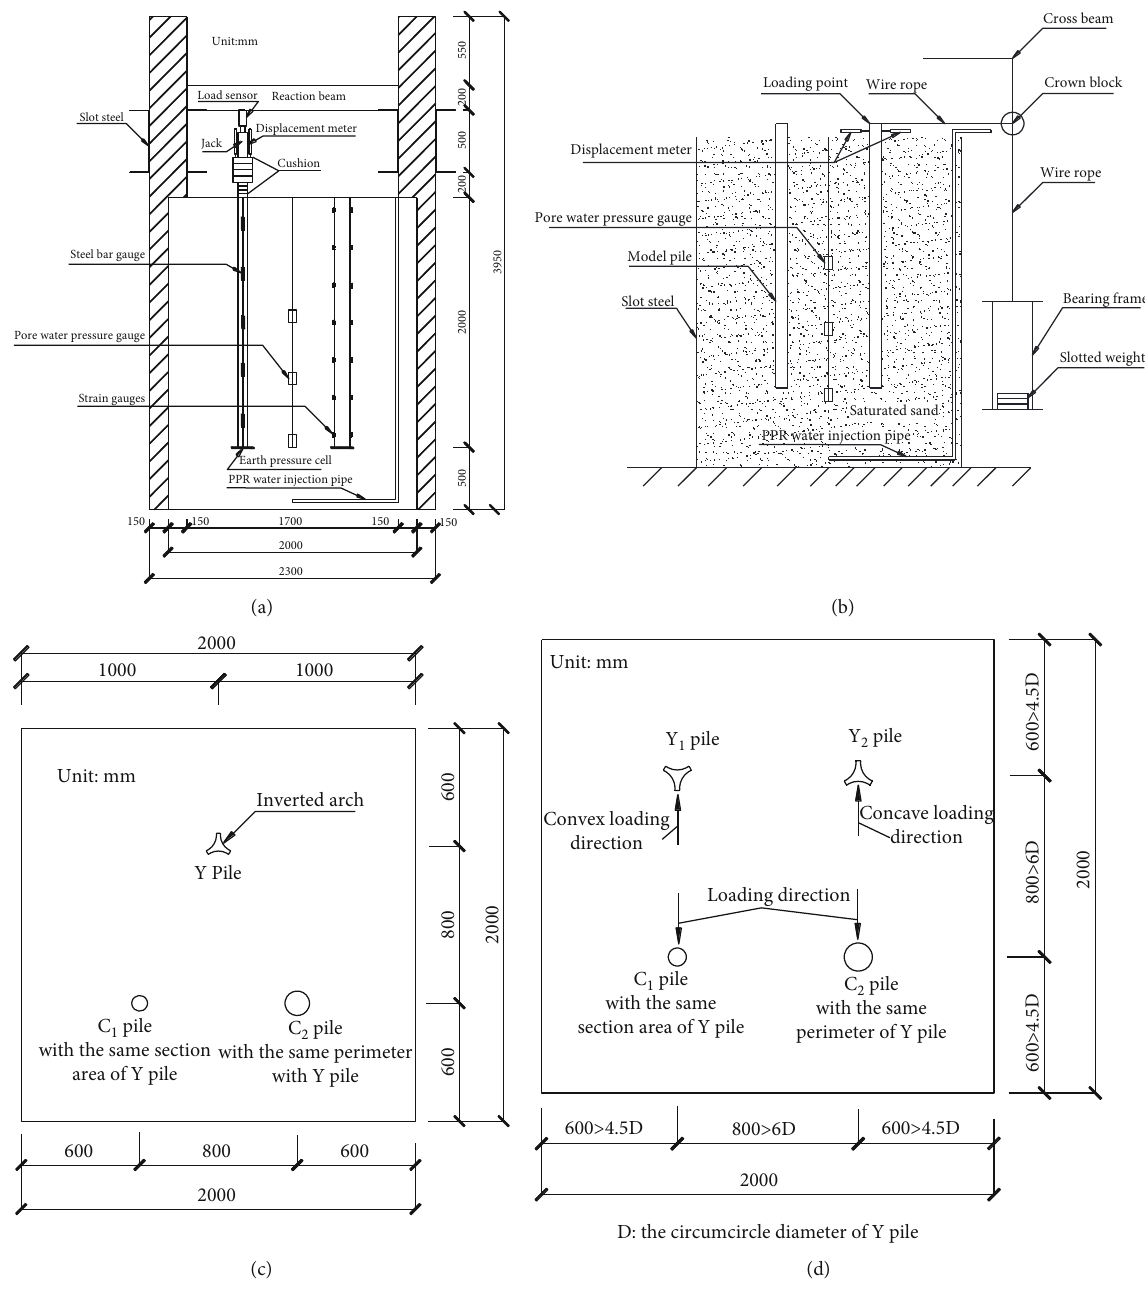
Figure 2: Layout of model tests: (a) loading and equipment system under compressive load; (b) loading system under lateral load; (c) cross- sectional view of three piles for compressive load tests; (d) cross-sectional view of four piles for lateral load